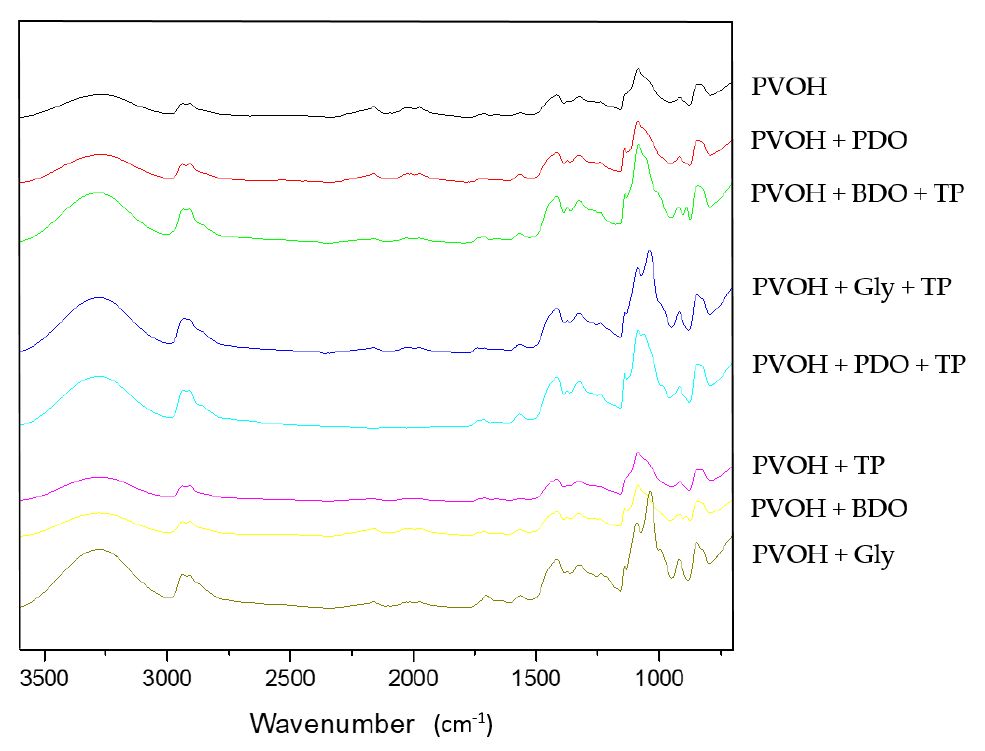
Figure 7. The FTIR results of PVOH-based biofilms plasticized with polyols and colored with tomato-based pigments.